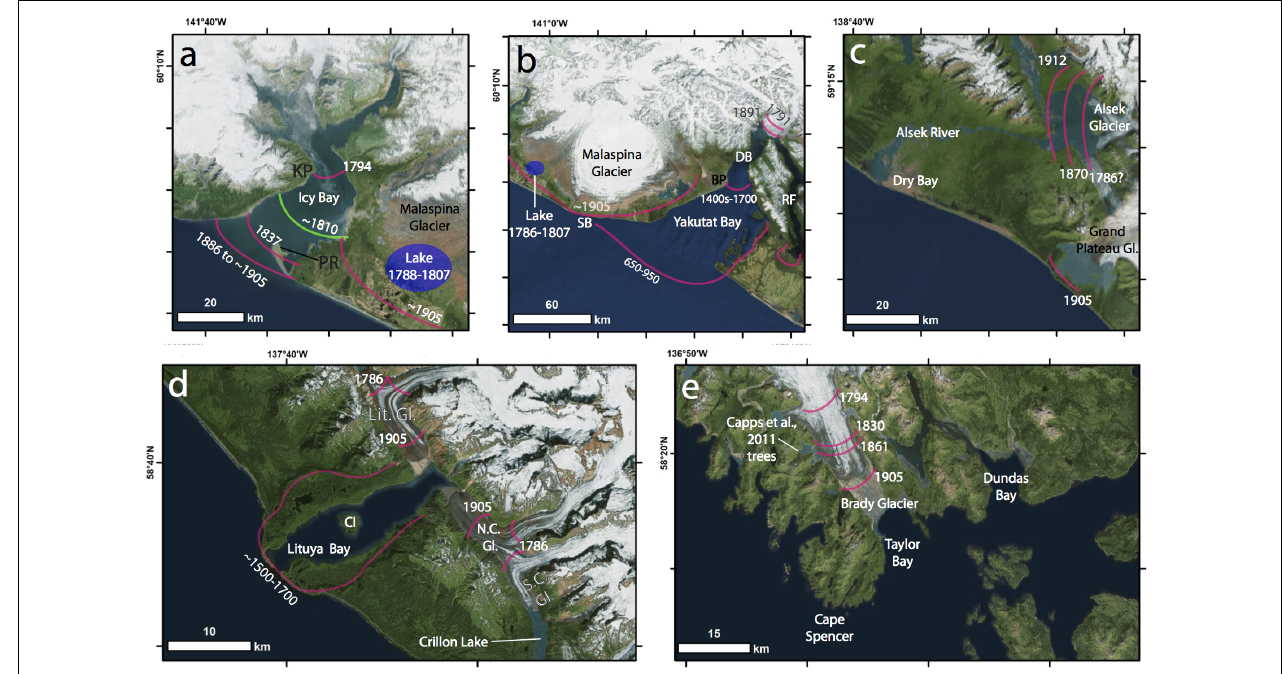
FIGURE 5 | Maps of individual bays and glaciers discussed in the text showing LIA termini positions). (a) Icy Bay: Kichyatt Point (KP), Point Riou (PR). (b) Malaspina Glacier: Yakutat Bay, Disenchantment Bay (DB), Russel Fjord (RF), Blizhni Point (BP). (c) Dry Bay, Alsek River mouth, and Grand Plateau Glacier. (d) Lituya Bay: Cenotaph Island (CI), Lituya Glacier (Lit. Gl.), North Crillon Glacier (N.C. Gl.), and South Crillon Glacier (S.C. Gl.), Crillon Lake. (e) Cape Spencer region: Brady Glacier, Dundas Bay. Glacier Bay is located immediately to the east of this